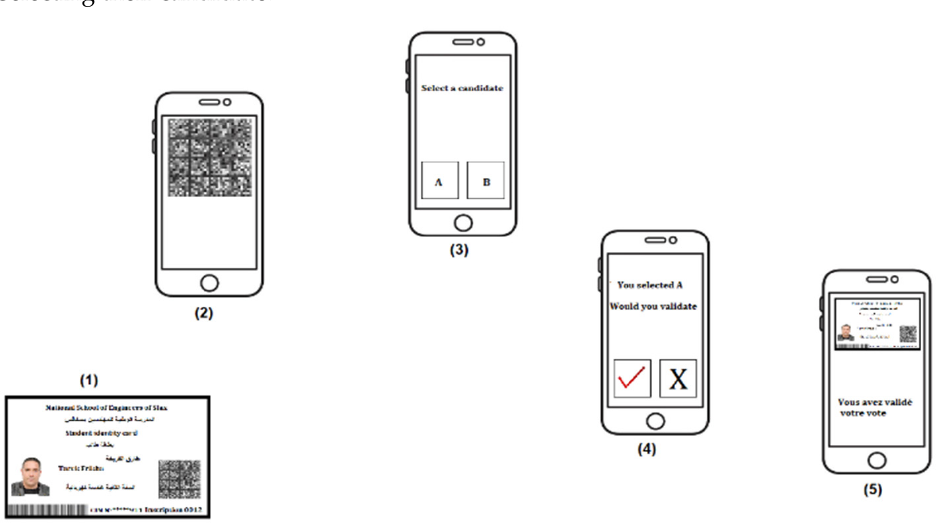
Figure 5. E-vote